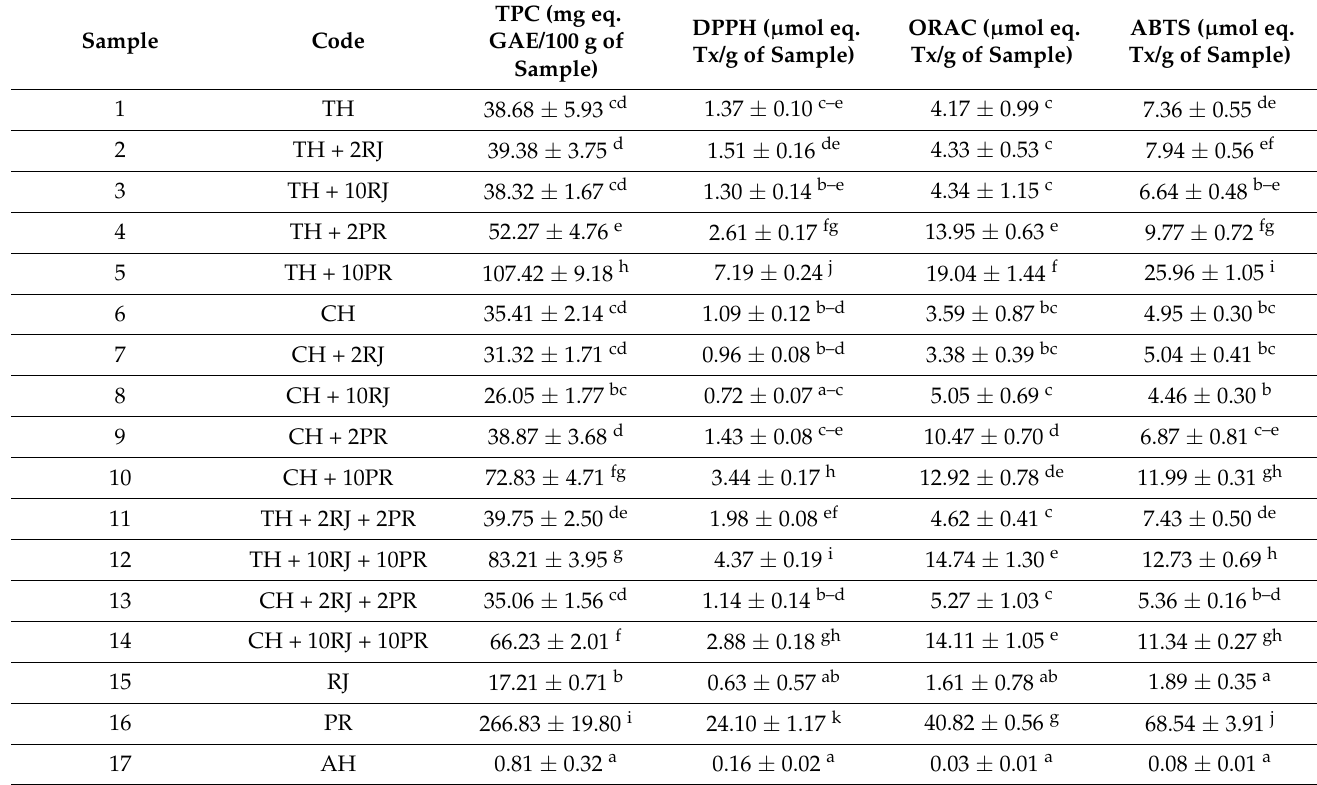
Table 4. TPC and antioxidant capacity of natural honey and supplemented with royal jelly and